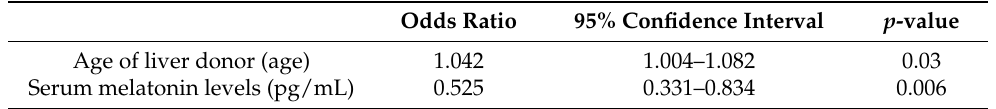
Table 2. Logistic regression analysis for the variables associated with one-year liver transplantation